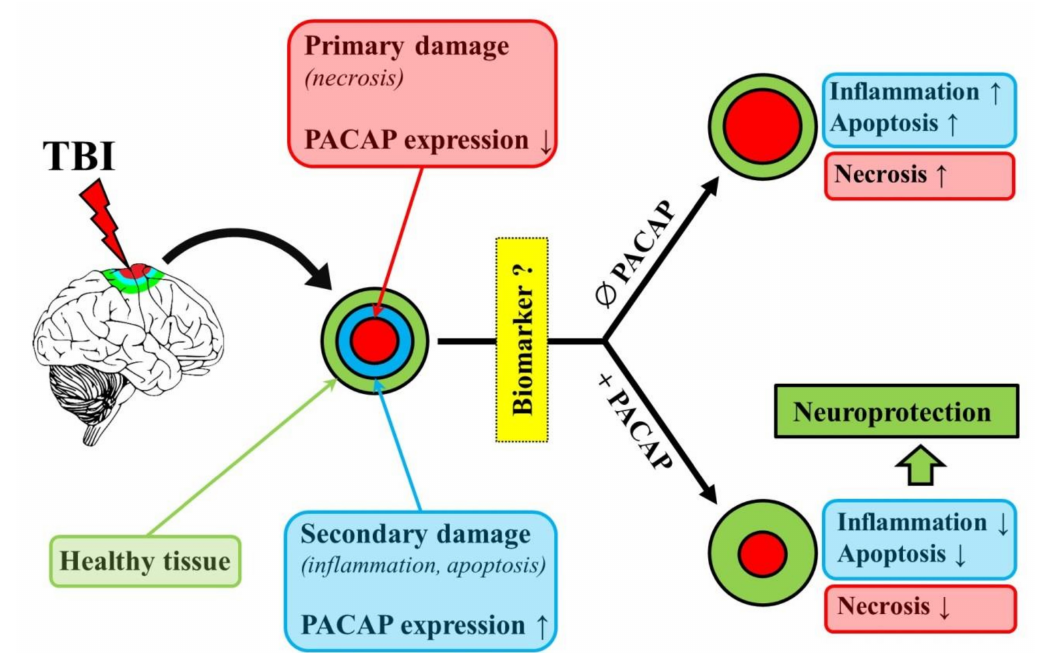
Figure 1. The neuroprotective and biomarker potential of pituitary adenylate cyclase activating polypeptide (PACAP). Red boxes and circles indicate primary damage after traumatic brain injury (TBI), blue boxes and circles show secondary damage, while green boxes and circles indicate healthy tissue or the process (neuroprotection) leading towards regenerated